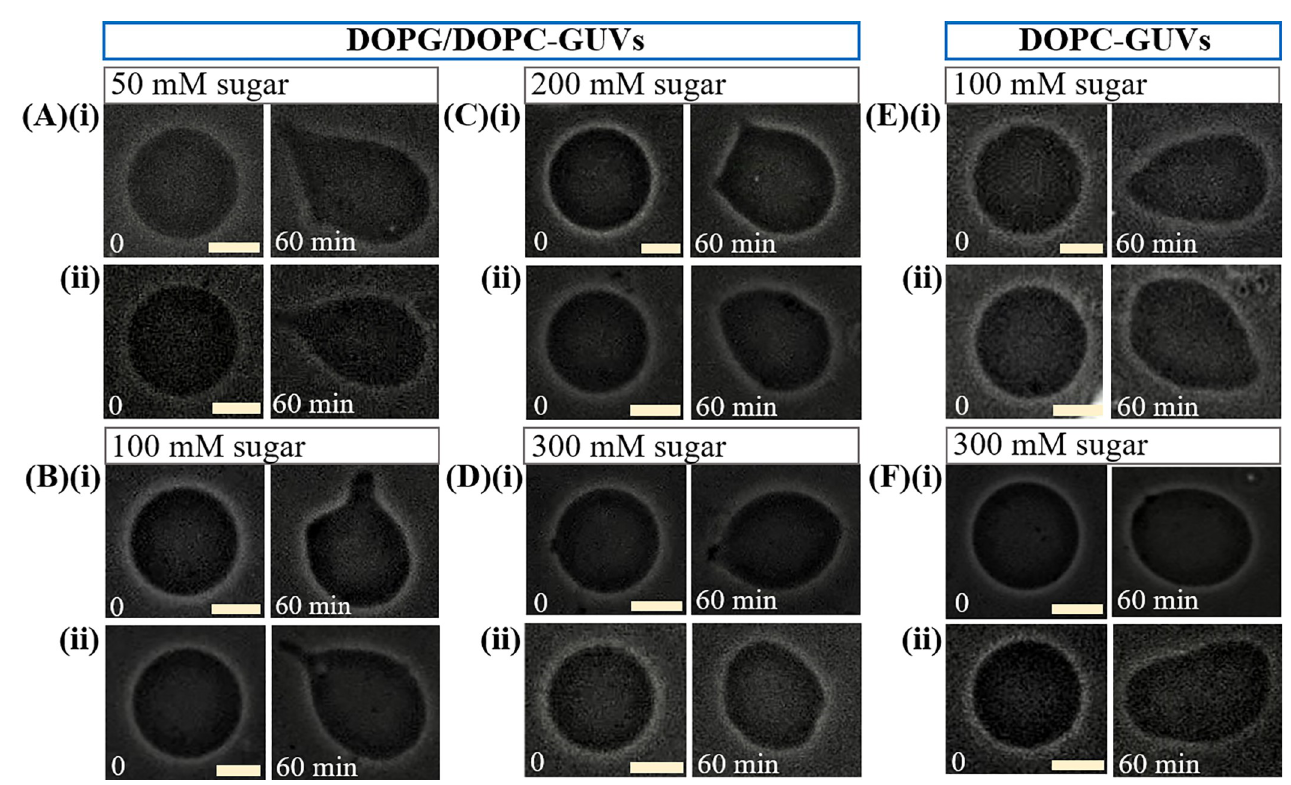
Fig 8. Different types of deformation of charged and neutral GUVs due to the interaction of 3.33 μ g/mL NPs under (A) 50 (B) 100 (C) 200 and (D) 300 mM sugar concentrations. The ‘common murre egg-shaped’ 40%DOPG/60%DOPC-GUVs in A(i, ii)) and B(ii); ‘winnoing fan-shaped’ 40%DOPG/60% DOPC-GUVs in B(i) and C(i); ‘oval-shaped’ 40%DOPG/60%DOPC-GUVs in C(ii) and D(i, ii); ‘common murre egg-shaped’ DOPC-GUVs in E(i, ii)), and ‘Oval-shaped’ DOPC-GUVs in F(i, ii). The bar corresponds to 15 μ m.